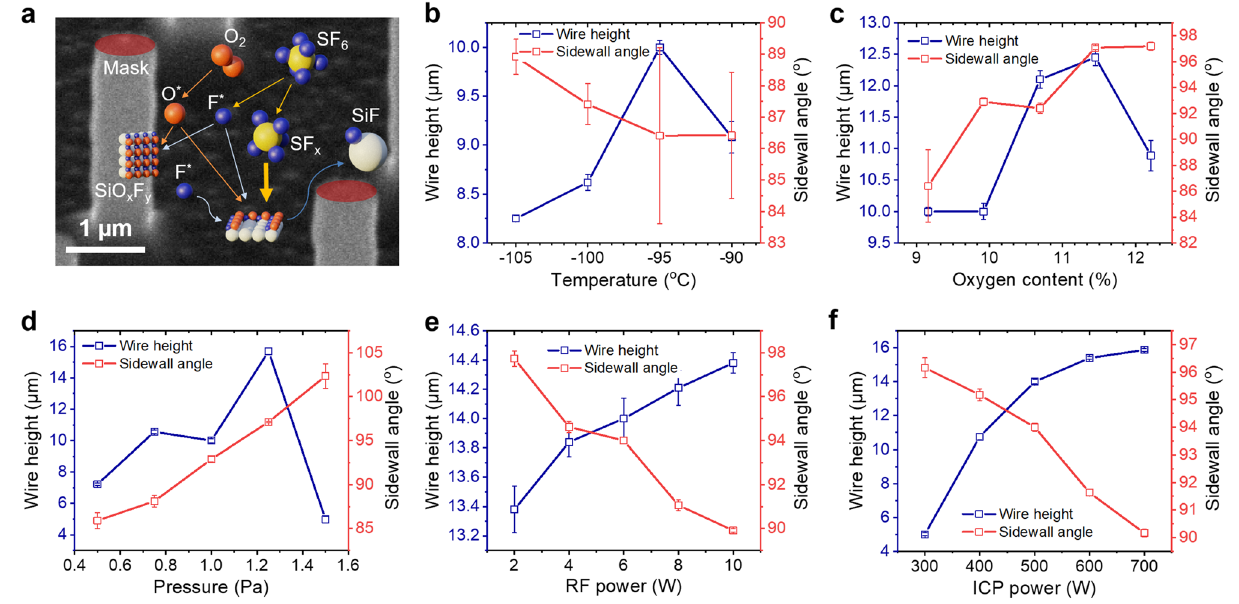
Figure 2. Etching mechanism and effects of the ICP-RIE processing parameters on the nanowire height and sidewall angle. ( a ) Scanning electron microscopy (SEM) image illustrating chemical species involved in the cryogenic dry etching process. Oxygen (O * ) and fluorine (F * ) form a passivation layer (SiO x F y ) on the nanowire sidewall as well as at the bottom part of Si at cryogenic temperatures. The physical bombardment of SF x ions triggered by the applied bias results in the removal of the bottom passivation layer. F radicals can react chemically with Si atoms at the bottom part forming volatile SiF x species, which are detached from the crystal, resulting in anisotropic etching. In this case, the mask at the top of the nanowire (in red color) acts as a shielding layer to prevent both physical and chemical etching processes. Various parameters, namely ( b ) temperature, ( c ) oxygen content, ( d ) pressure, ( e ) radio-frequency (RF) power, and ( f ) ICP power affect the height and sidewall angle of Si